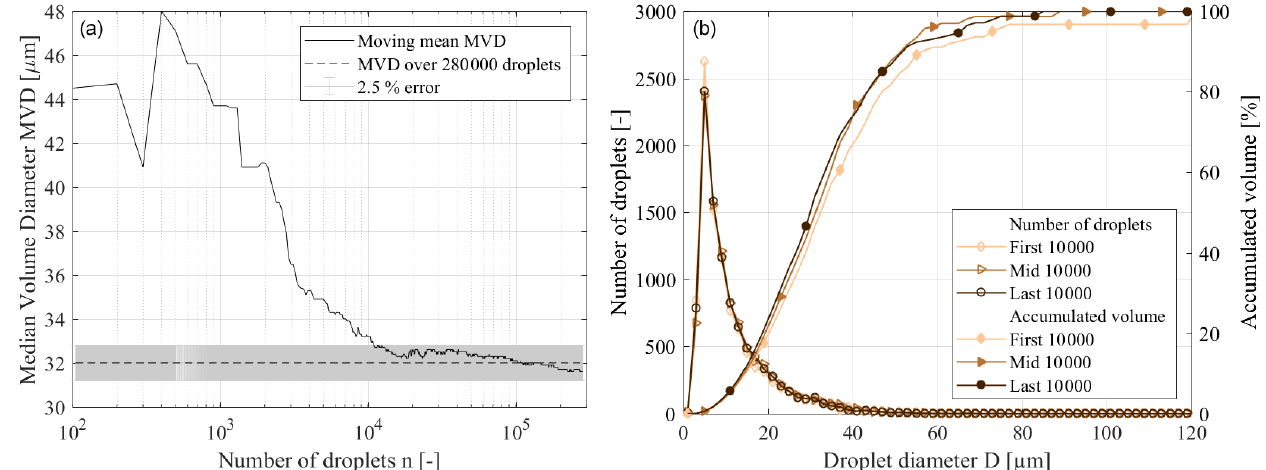
Figure 6. Convergence of MVD over number of droplets at 40ms − 1 and temporal stability (PDI run 9 August 2017 17:59LT).